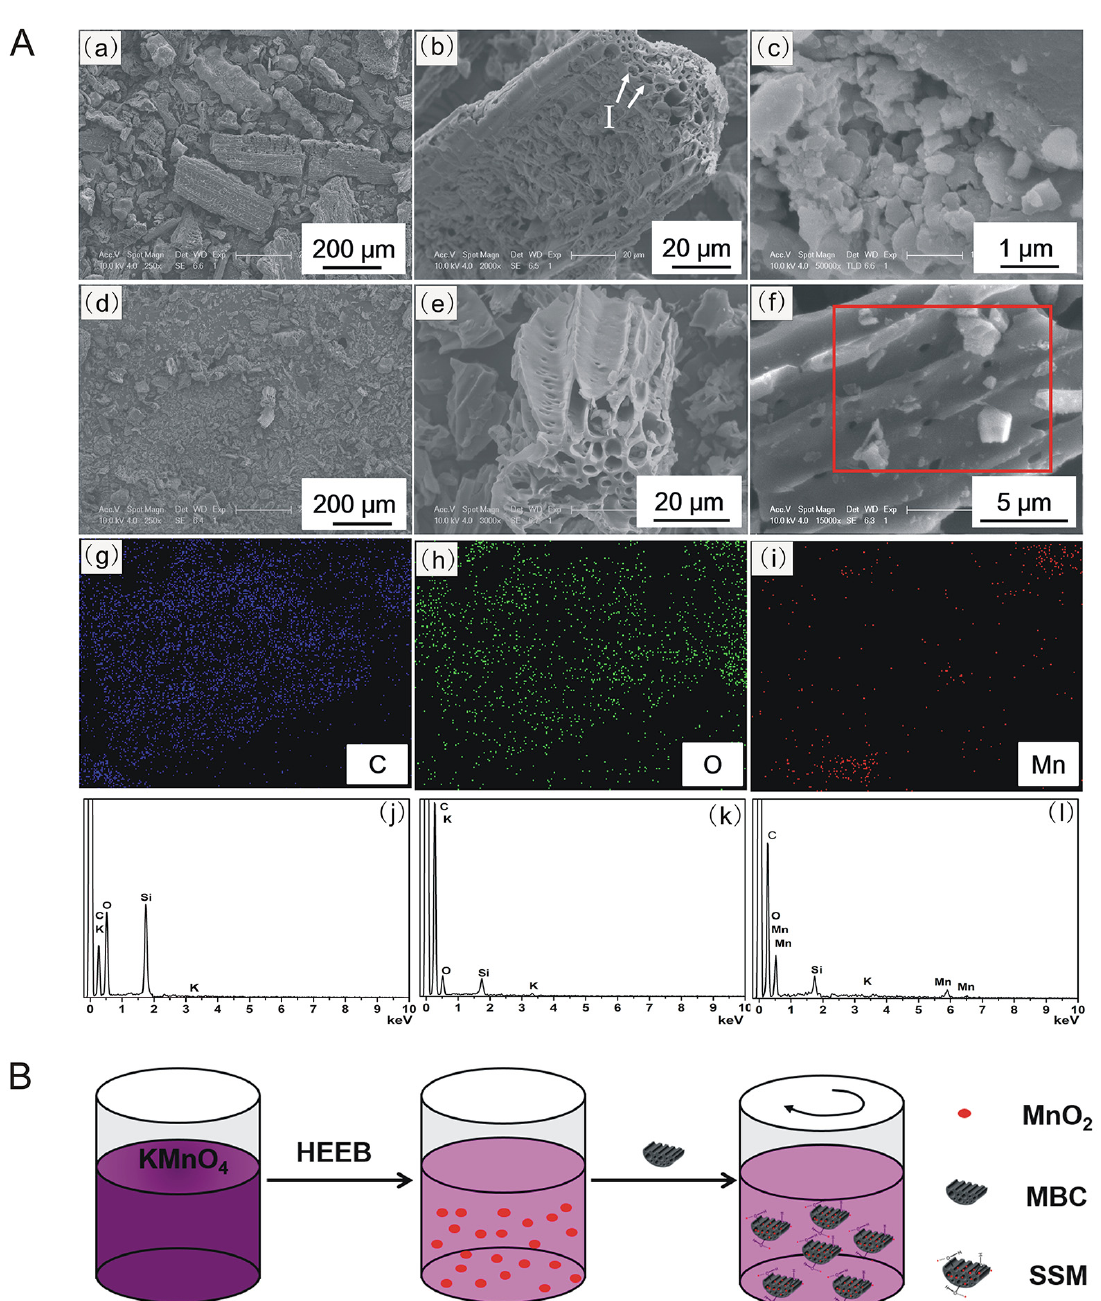
Figure 1. ( A ) SEM images of ( a , b ) BC; ( c ) MnO 2 ; ( d , e ) MBC; ( f ) longitudinal section of MnO 2 /MBC (W MnO2 /W MBC = 1:2); ( g – i ) distribution maps of C, O, and Mn in MnO 2 /MBC (W MnO2 /W MBC = 1:2); ( j – l )